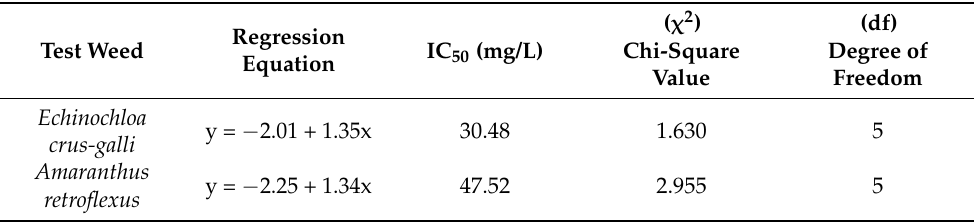
Table 1. Determination of toxicity of berberine to root length of Echinochloa crus-galli and Amaranthus retroflexus.